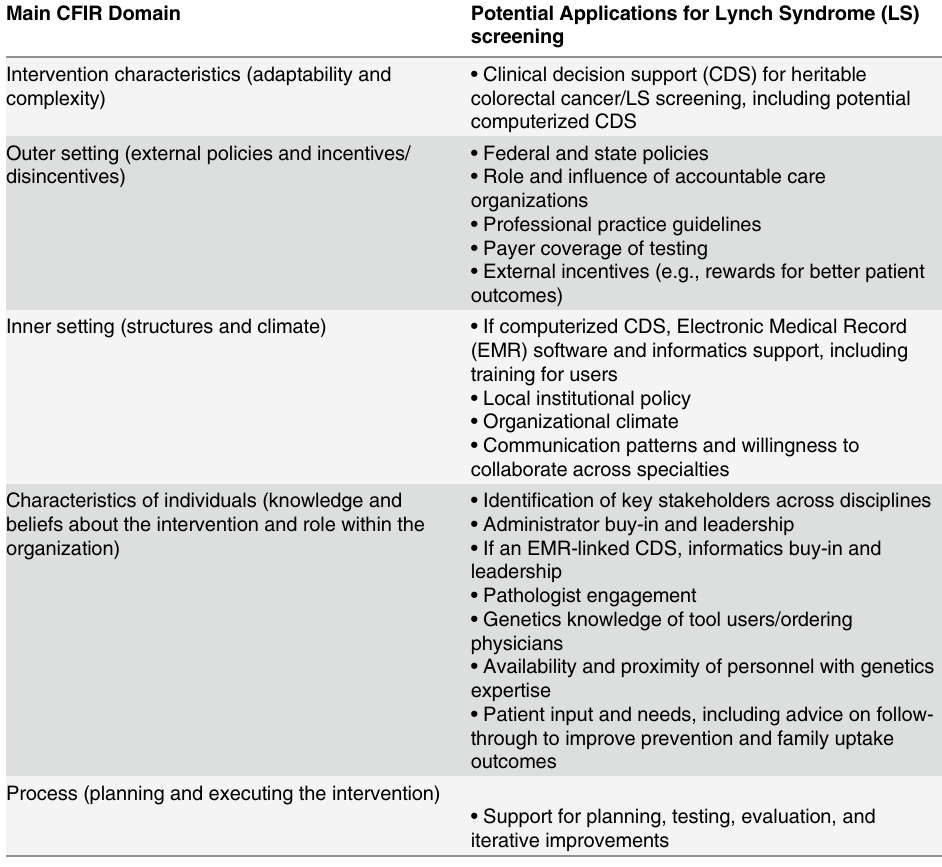
Table 1. Consolidated Framework for Implementation Research (CFIR) domains and Lynch Syndrome screening